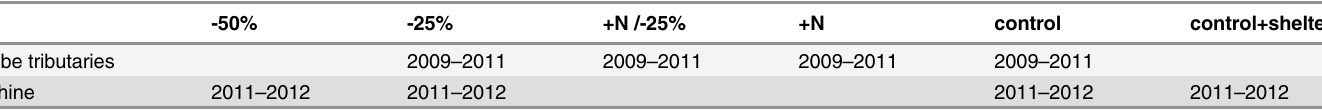
Table 1. Overview of experimental treatments of the precipitation reduction experiments at the Elbe tributaries and the Rhine: -50% = 50% precipi- tation reduction;-25% = 25% precipitation reduction; +N = fertilization with N; control = controls without rainout shelters; control+shelter = controls with rainout